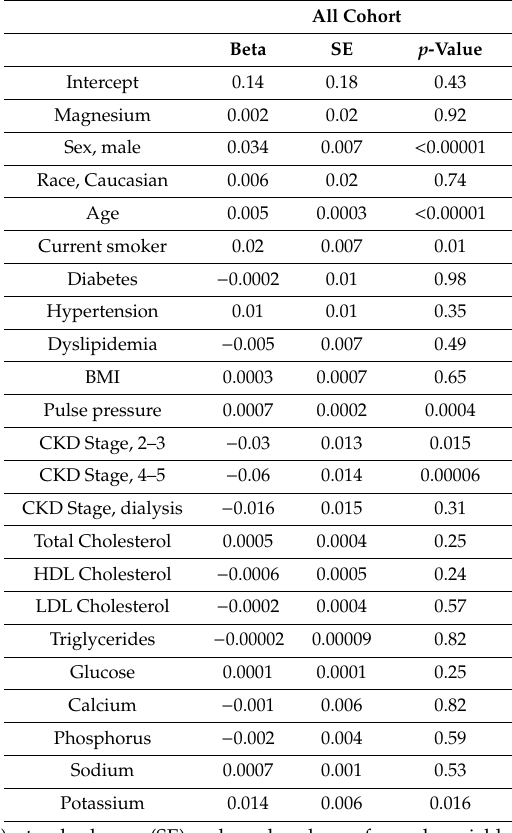
Table 3. Multivariate linear main e ff ects model for